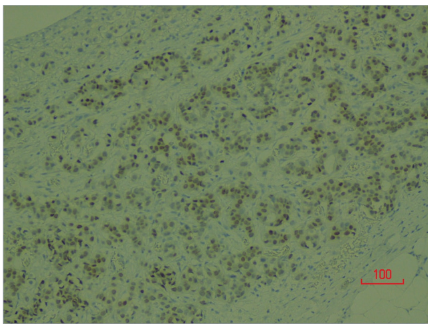
Figure 3: ER positive tumor cells invading the intra-abdominal adipose